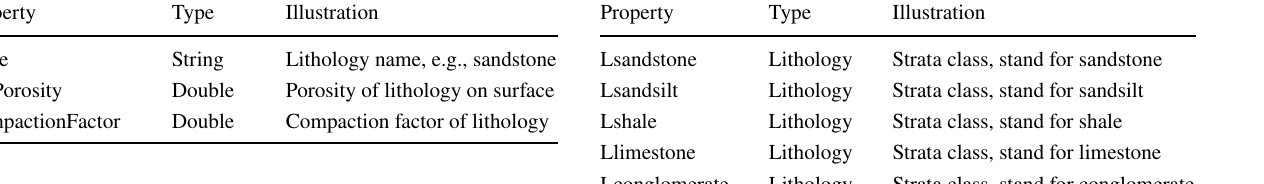
Table 5 Lithology templates class (lithology class)